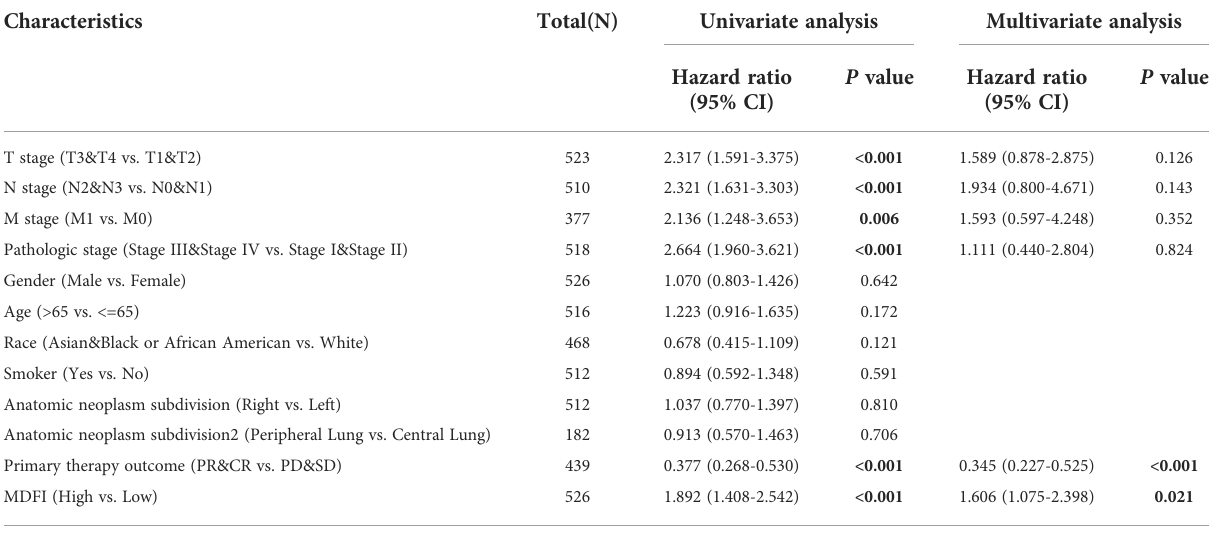
TABLE 3 Univariate and multivariate Cox regression analyses of clinical characteristics associated with overall survival.